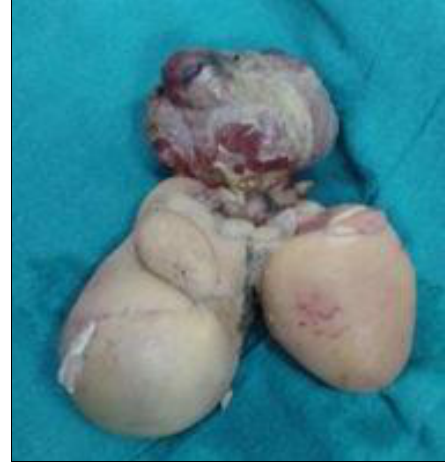
Figure 2: Gross morphology of sacral parasite twin with rudimentary